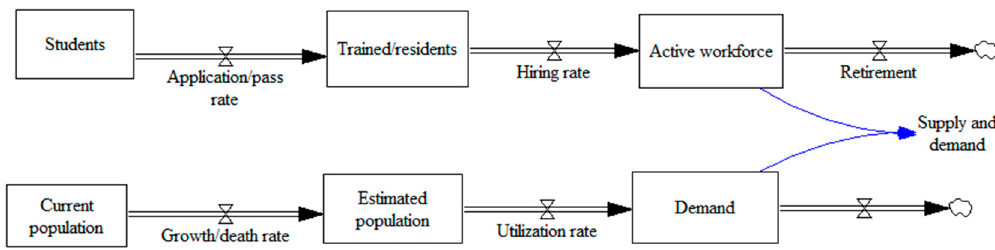
Figure 7. The core part of the stock-flow diagram for workforce demand.